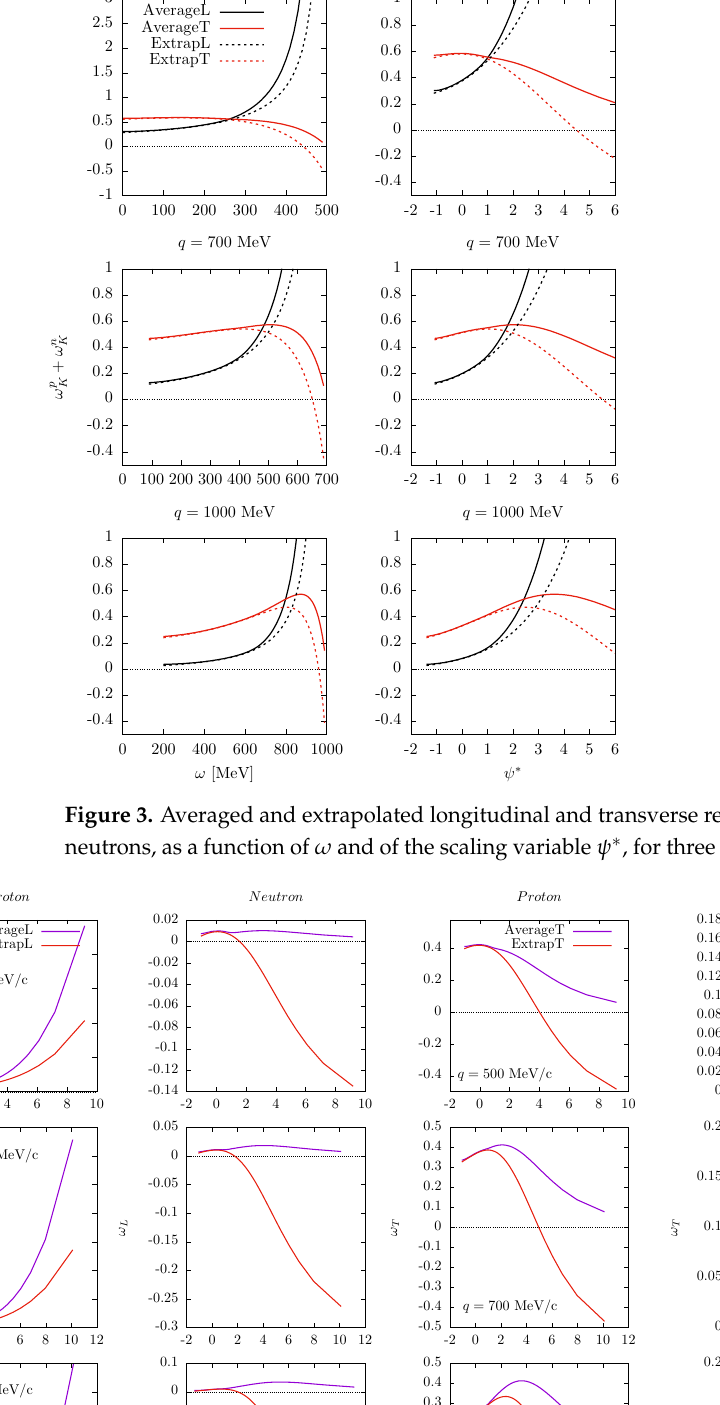
Figure 4. Averaged and extrapolated longitudinal and transverse response functions for protons and neutrons, as a function of the scaling variable and for three values of the momentum